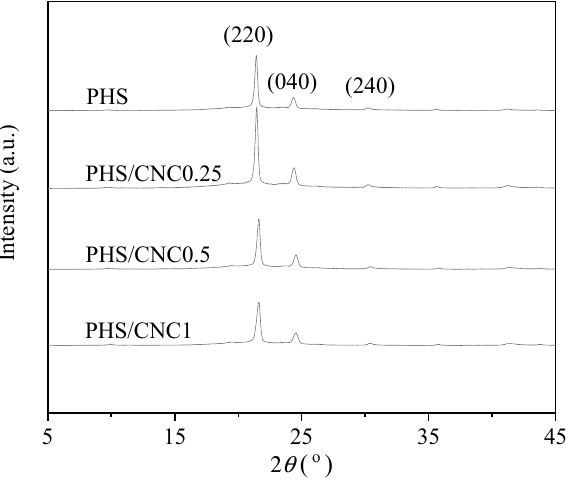
Figure 8. WAXD patterns of PHS and PHS/CNC composites.